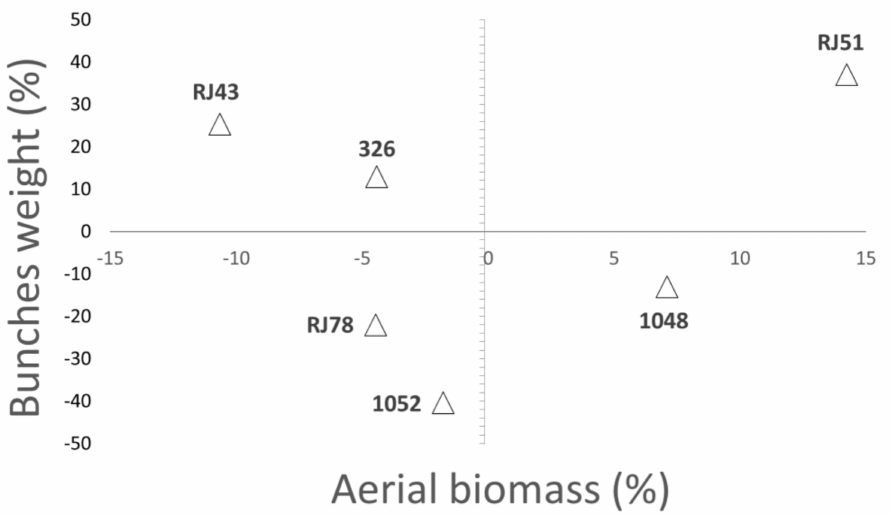
Figure 2. Representation of bunches and aerial biomass (leaves and stem) of the different clones, expressed as deviation in respect to their average. Aerial biomass (x-axes) and bunches weight (y-axes). Positive/negative values indicate the particular genotype position.